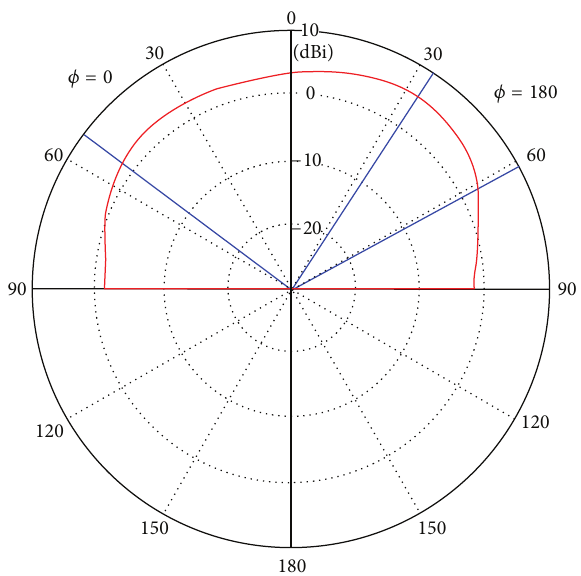
Figure 8: Simulated antenna radiation pattern (directivity) in 𝑥𝑧 - plane ( 𝜑 = 0 ∘ ) at 𝑓 = 900 MHz.